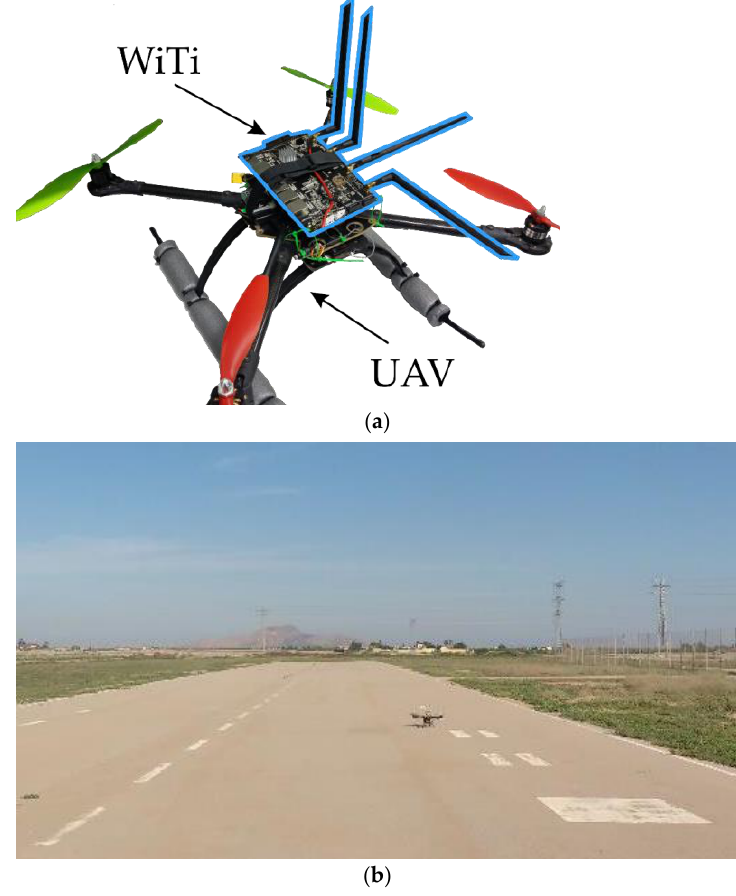
Figure 1. ( a ) UAV with WiFi communication module (WiTi). ( b ) Flying field, “Los Halcones de la Rambla”, Murcia, Spain.